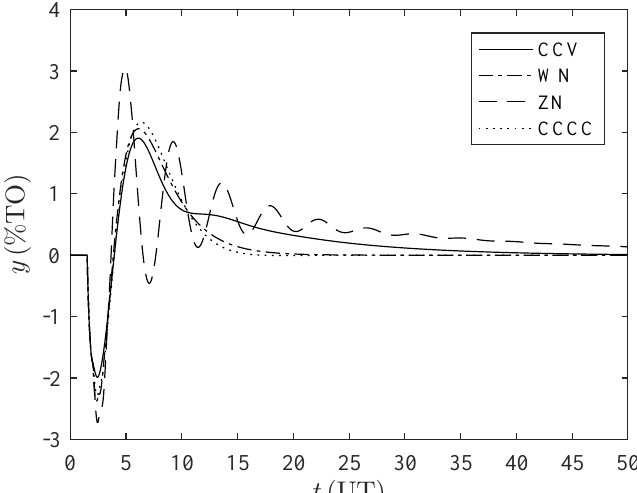
Figure 5. Time response disturbance rejection for the set P 4 . %TO: percentage of transmitter output, UT: units of time.